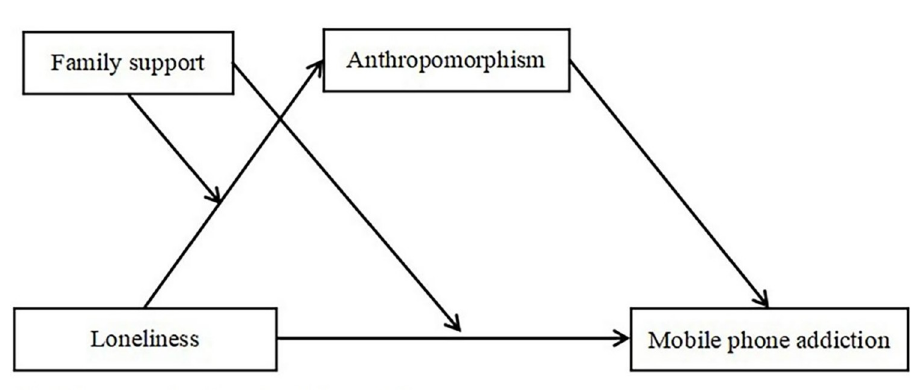
Fig 1. The proposed moderated mediation